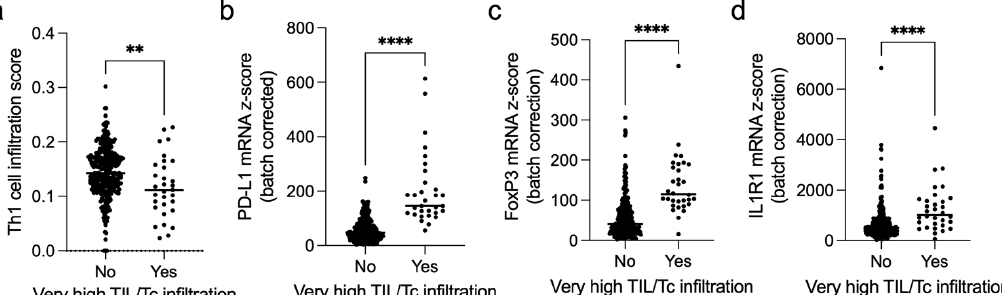
Figure 5. Unfavourable tumour microenvironment in the “very highly” infiltrated CRCs in the TCGA cohort. ( a ) Th1 infiltration score as measured by xCell [33] in the “low/highly infiltrated” vs. “very highly infiltrated” tumours (median 0.14 vs. 0.11, respectively, p = 0.004). ( b ) PD-L1 expression in the “low/highly infiltrated” vs. “very highly infiltrated” tumours (median z -score 47.3 vs. 145.7, respectively, p < 0.001). ( c ) FOXP3 expression in the “low/highly infiltrated” vs. “very highly infiltrated” tumours (median 41.32 vs. 115.70, respectively, p < 0.001). ( d ) IL1R1 expression in the “low/highly infiltrated” vs. “very highly infiltrated” tumours (median 510.3 vs. 1026, respectively, p < 0.001). ** p <0.01; **** p < 0.0001